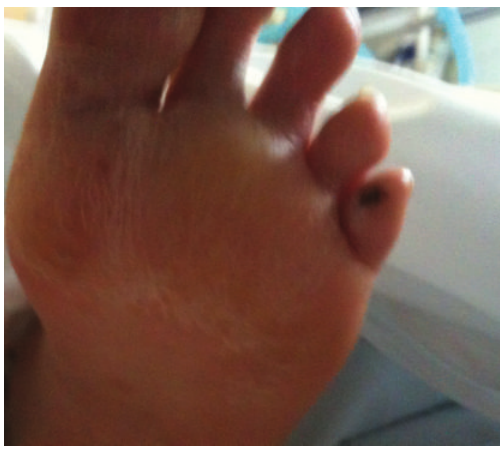
Figure 1: Skin lesion on the left foot.